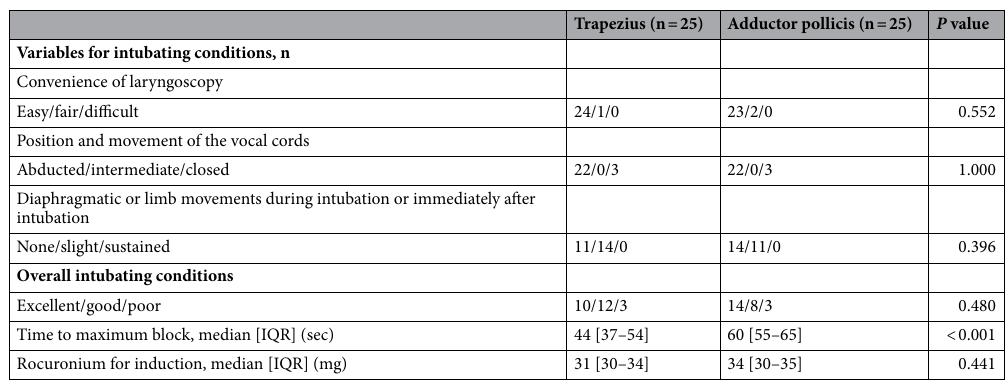
Trapezius (n = 25) Adductor pollicis (n = 25) P